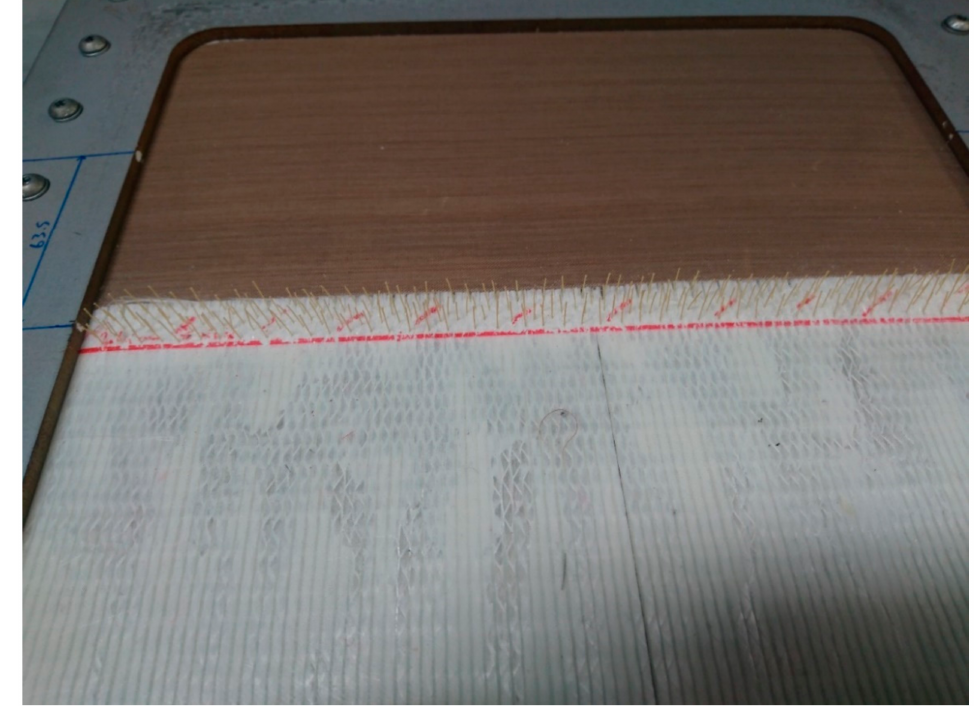
Figure 11. Case-4 samples prior to undergoing